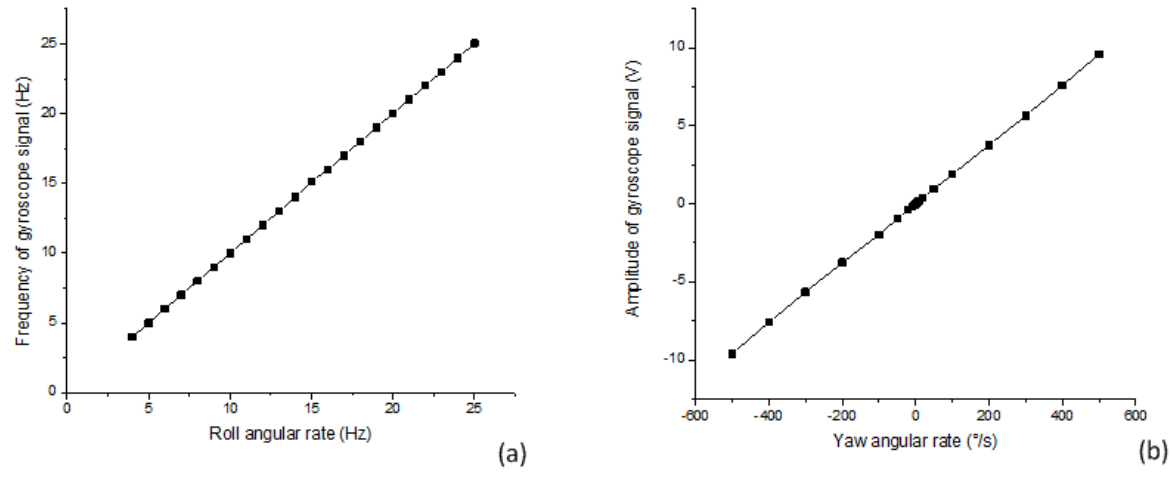
Figure 3. ( a ) Frequency of gyroscope signal as a function of roll angular rate; ( b ) Amplitude of gyroscope signal as a function of yaw angular rate.